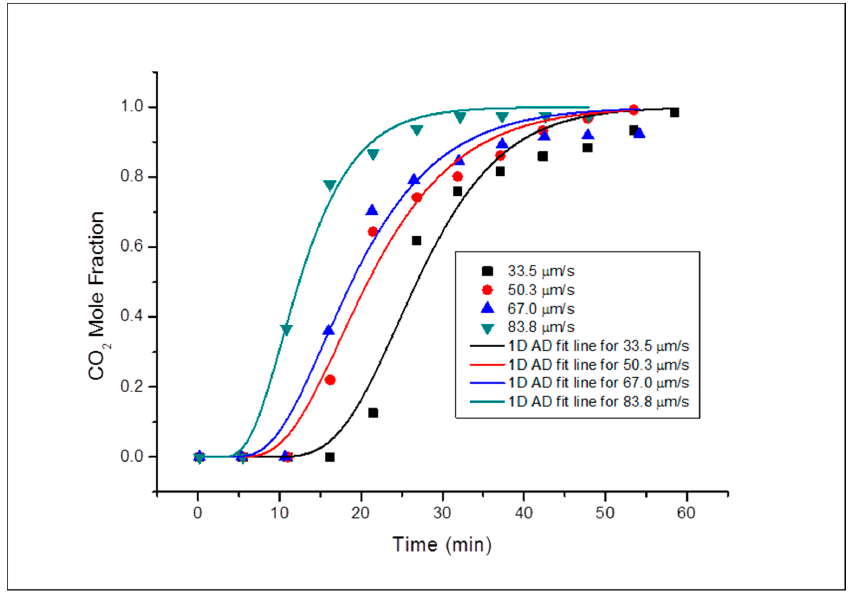
Figure 4. Concentration profile for all Grey Berea runs vertical orientation.